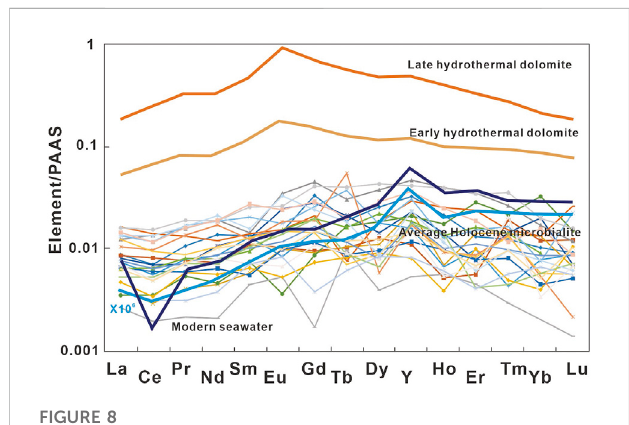
FIGURE 8 PAAS-normalized patterns of REE + Y of matrix dolostones. (The REE +Y patterns of the modern seawater and Holocene microbialites, andhydrothermaldolomitesarefromWebbandKamber,2000;Nutman et al., 2010).